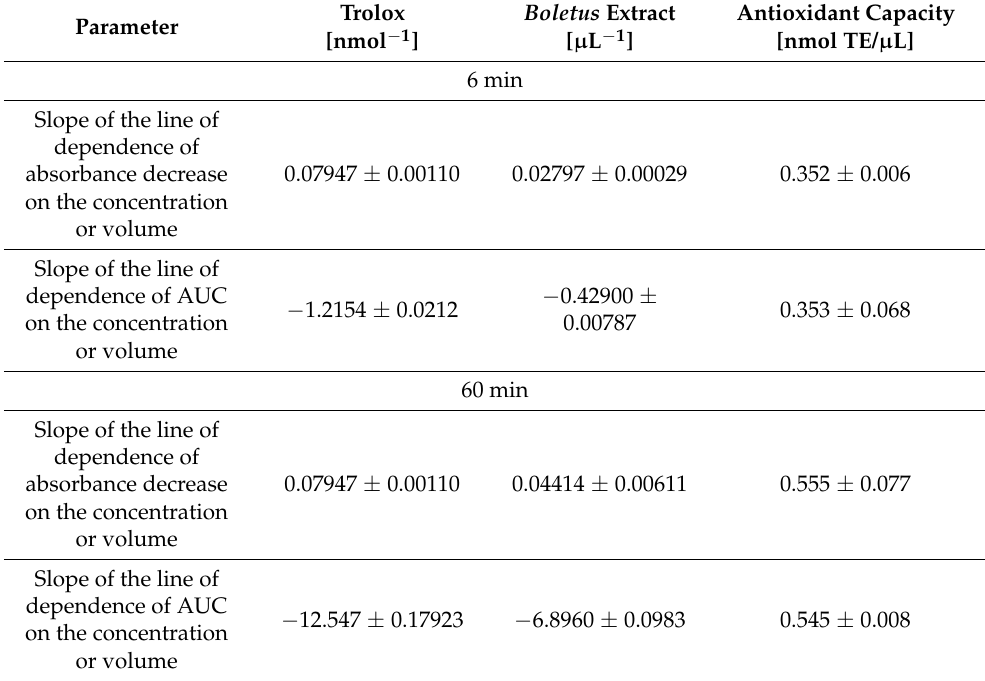
Figure 10. Dependence of absorbance decrease and AUC on the volume of Boletus extract after 6 min and after 60 min. Measurements were taken every 30 s. Table 3. Calculation of the antioxidant capacity of Boletus extract, based on the dependence of absorbance decrease and AUC on extract volume.